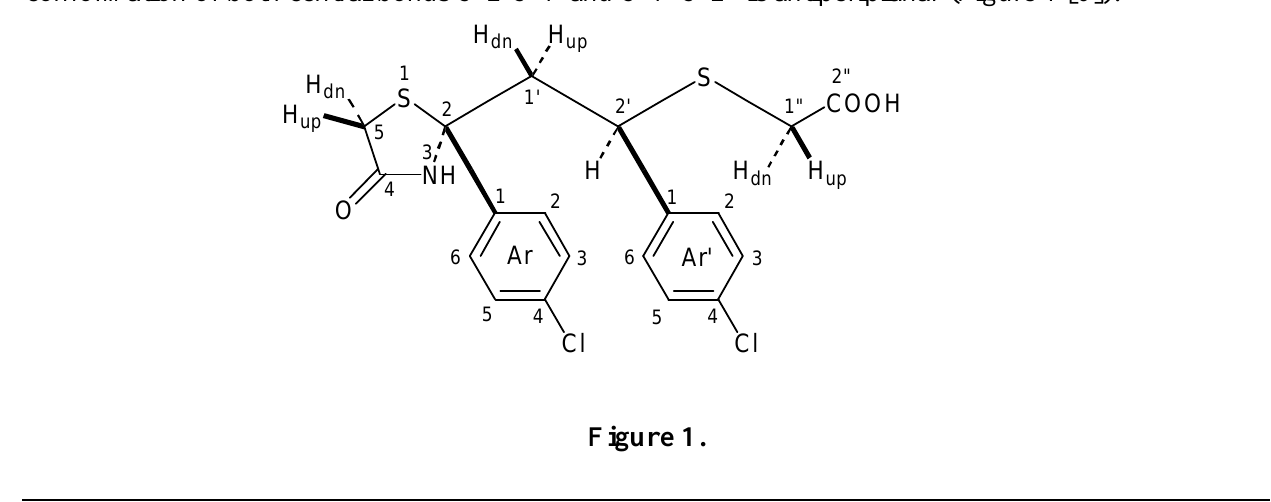
Table 1. 1 H-NMR data of ( 1